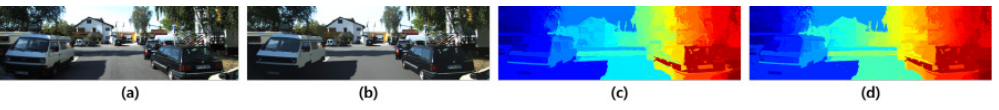
Figure 2. Procedure from pre-processing to semantic grouping on CCD image data. ( a ) Input image data; ( b ) color-flattened image; ( c ) segmented image using the graph-segmentation method; ( d ) semantic grouping using the dissimilarity cost